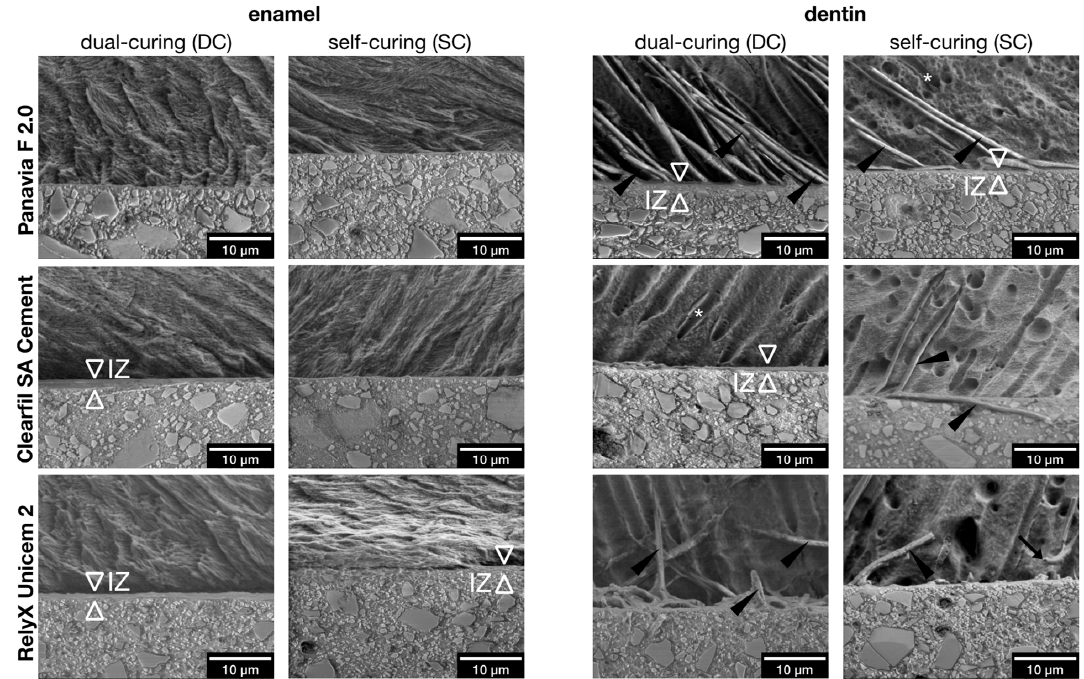
Figure 7. Adhesive interface micromorphology in polished specimens after demineralization and deproteinization (experiment 2; original magnification ×6000). Left panel: Adhesive interface micromorphology in specimens from all luting agents with enamel in DC and SC mode after demineralization and deproteinization. Thin interdiffusion zones (IZ) were visible. Right panel: Adhesive interface micromorphology in specimens from all luting agents with dentin in DC and SC mode after demineralization and deproteinization. Interdiffusion zones (IZ), tag-like structures (black arrow heads) and tags with inner hollow spaces (black arrows) and laminae limitantes (surrounding *) are visible in representative micrographs.